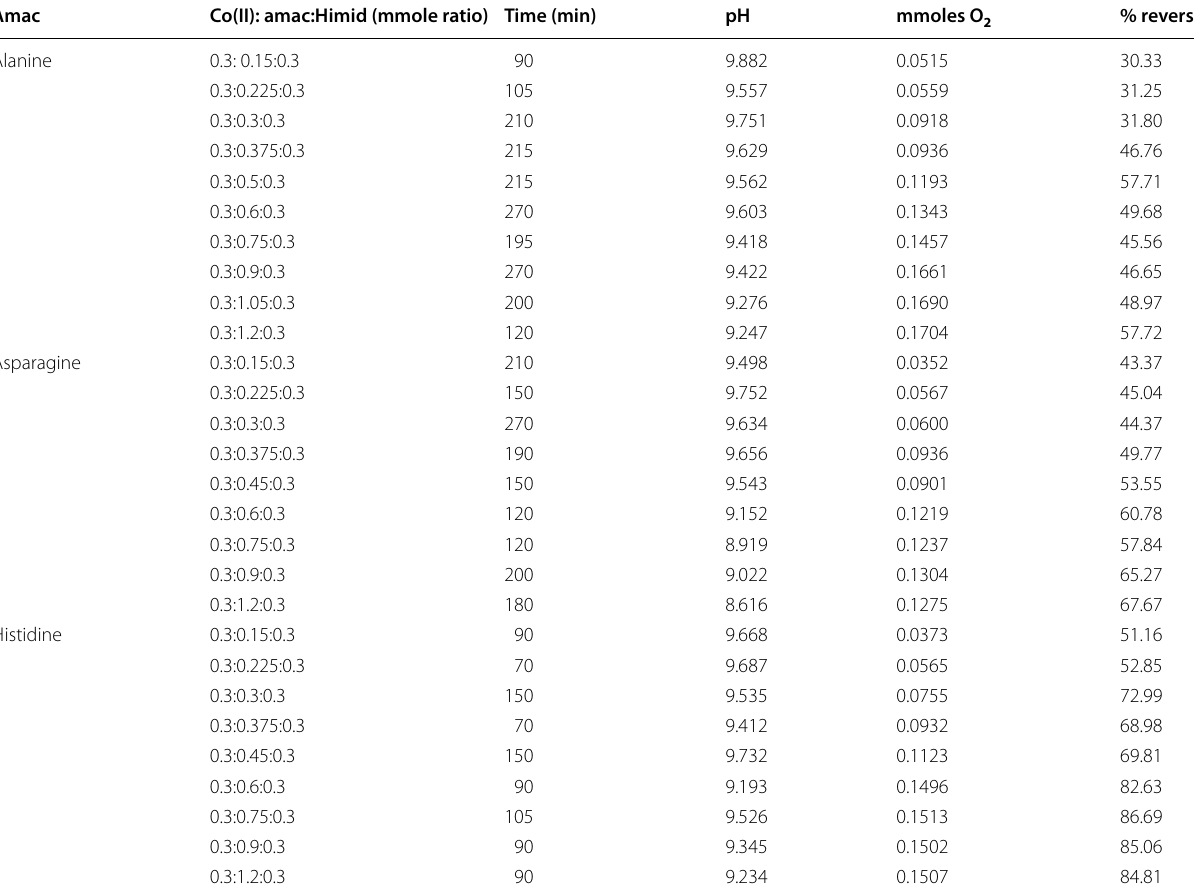
Table 1 Uptake of O by the Co(II)– l - α-amino acid–imidazole systems (duration time of uptake, final value of pH, number 2 of mmoles of O bound, percentage of reversibility) 2